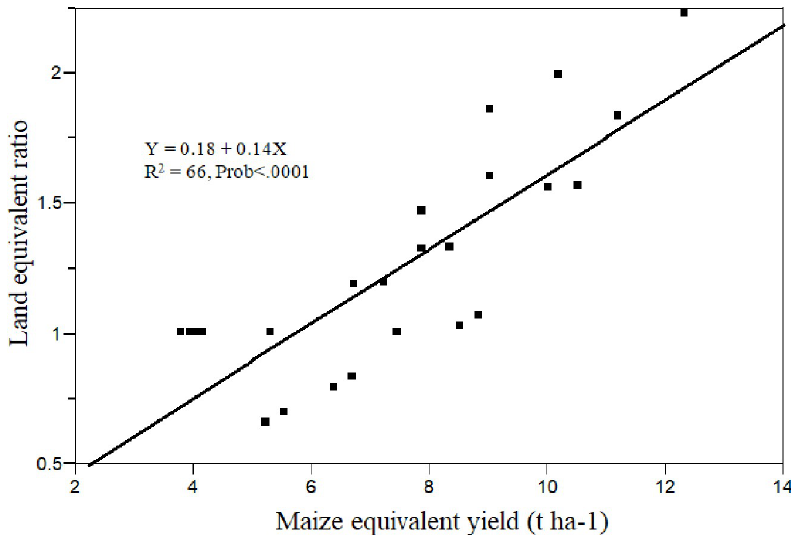
Fig 5. The relationship between the MEY and LER as affected by spatial arrangement and planting date of common bean inmaize-common bean intercropping.